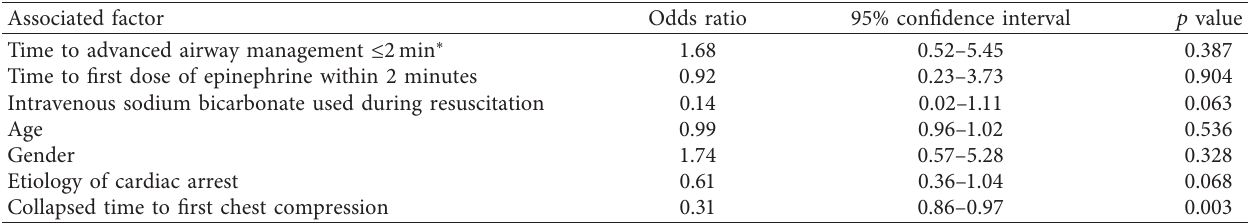
Table 4: Odds ratio from multivariable logistic regression predicting survival to hospital discharge with favorable neurological outcome from time to advance airway management ≤ 2 minutes and > 2